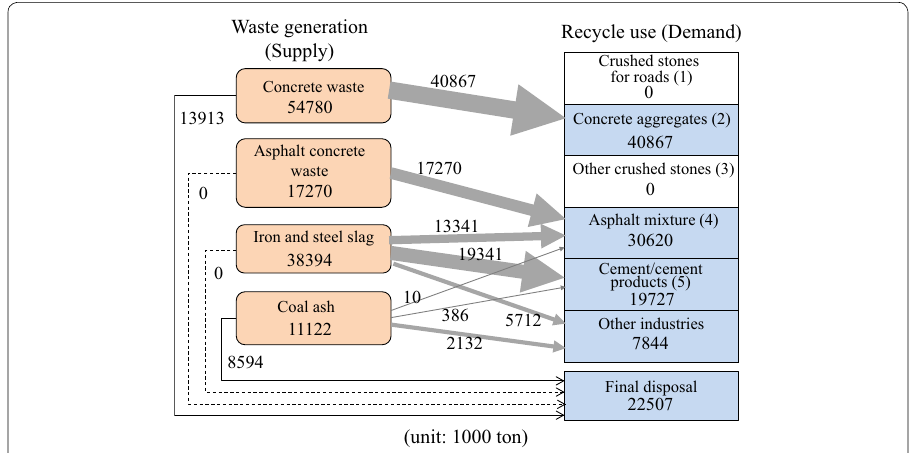
Fig. 4 Material flows of non-metallic mineral wastes in 2030 (BAU scenario)